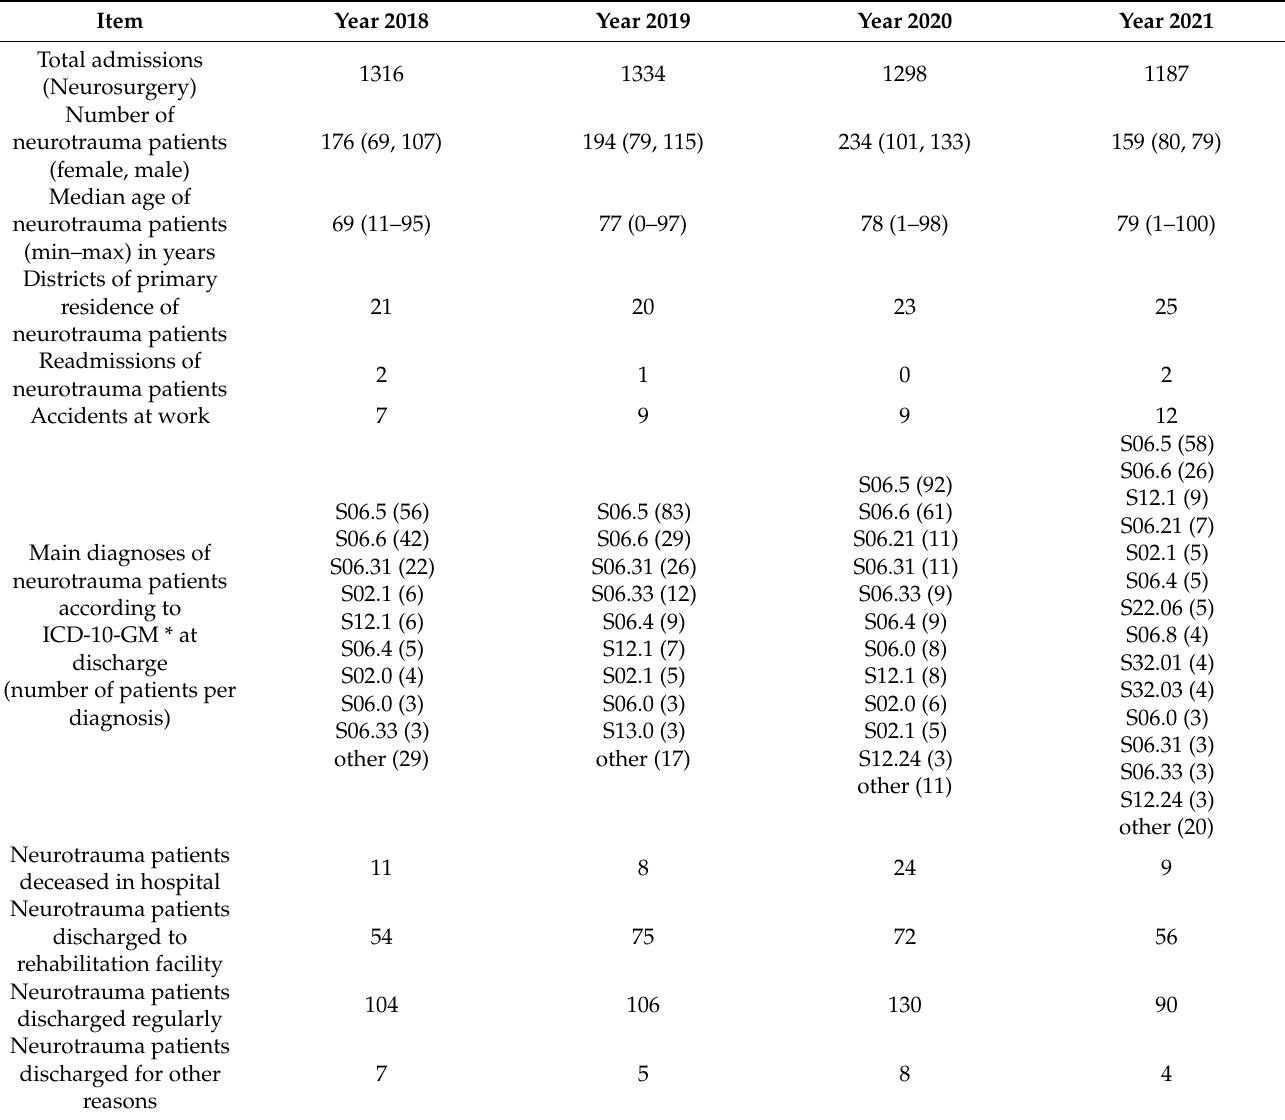
Table 1. Descriptive data of 763 consecutive neurotrauma